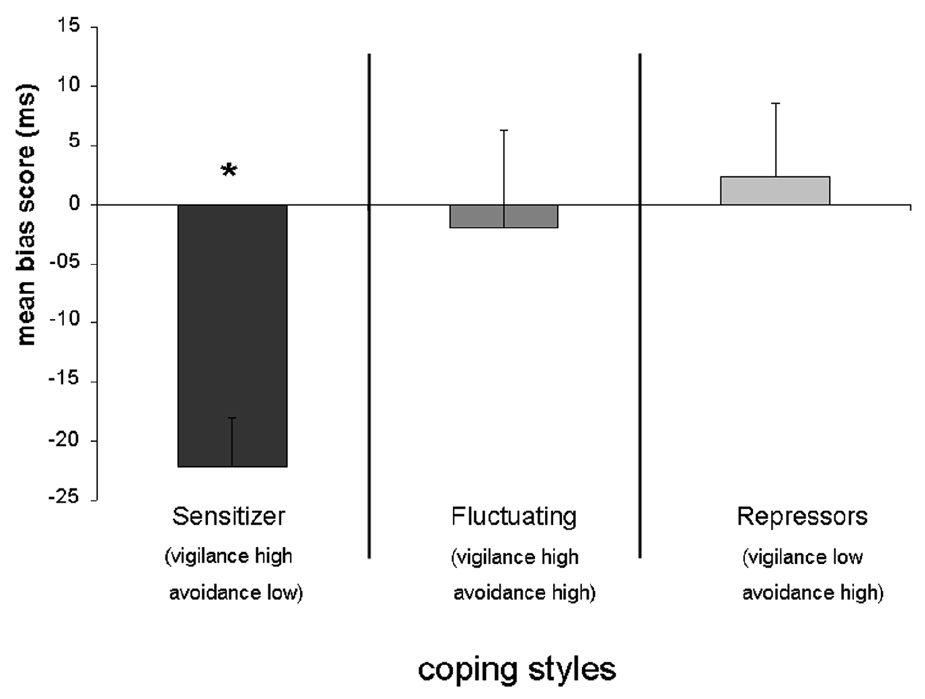
Figure 1. Mean bias scores (gaze duration viewing positive faces – gaze duration viewing threatening faces) of sensitizers, fluctuating subjects, and repressors (and standard errors of the mean) during the first interval 500 ms. The asterisk indicates that the bias score significant differs from zero. **: p , .01.